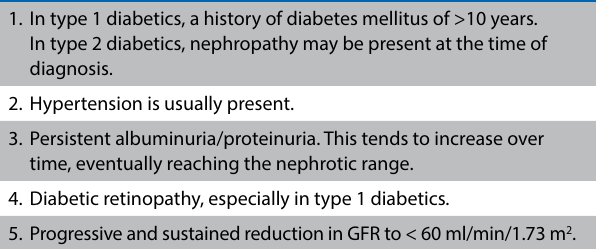
Table II. Criteria for the diagnosis of overt diabetic nephropathy 18,19